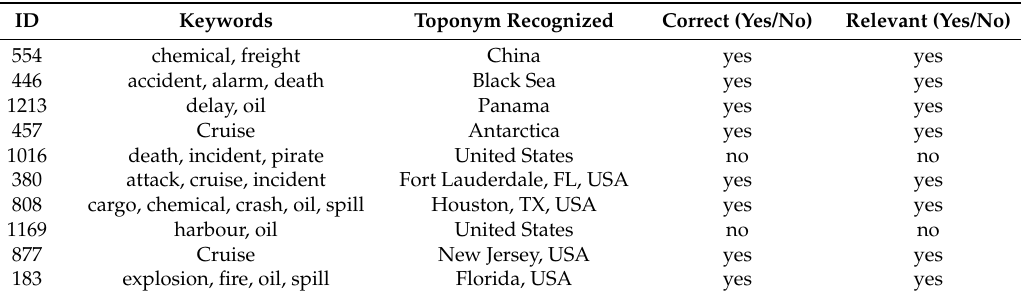
Table 1. Sample analysis of ten randomly sampled